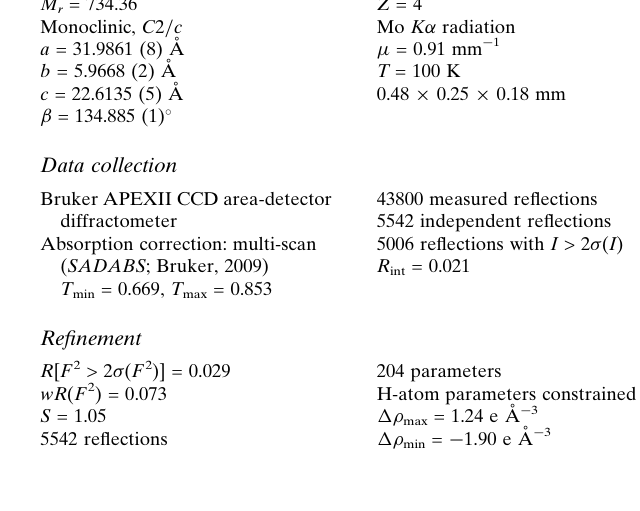
Hydrogen-bond geometry (A˚ , (cid:3)